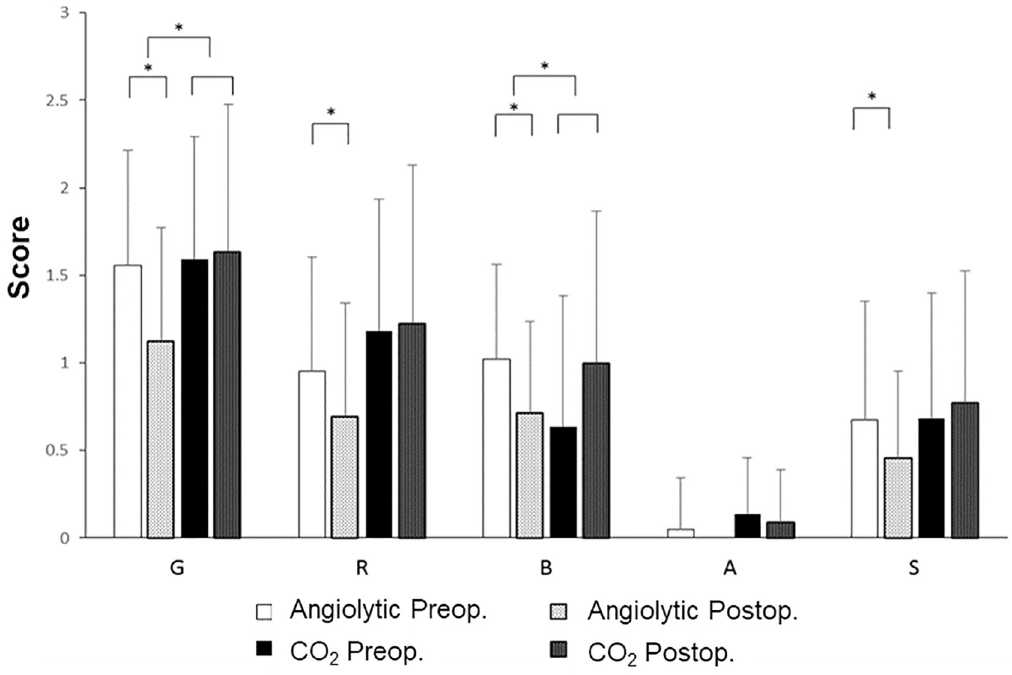
Fig 4. Preoperative and postoperative GRBAS (grade, roughness, breathiness, asthenia, and strain)